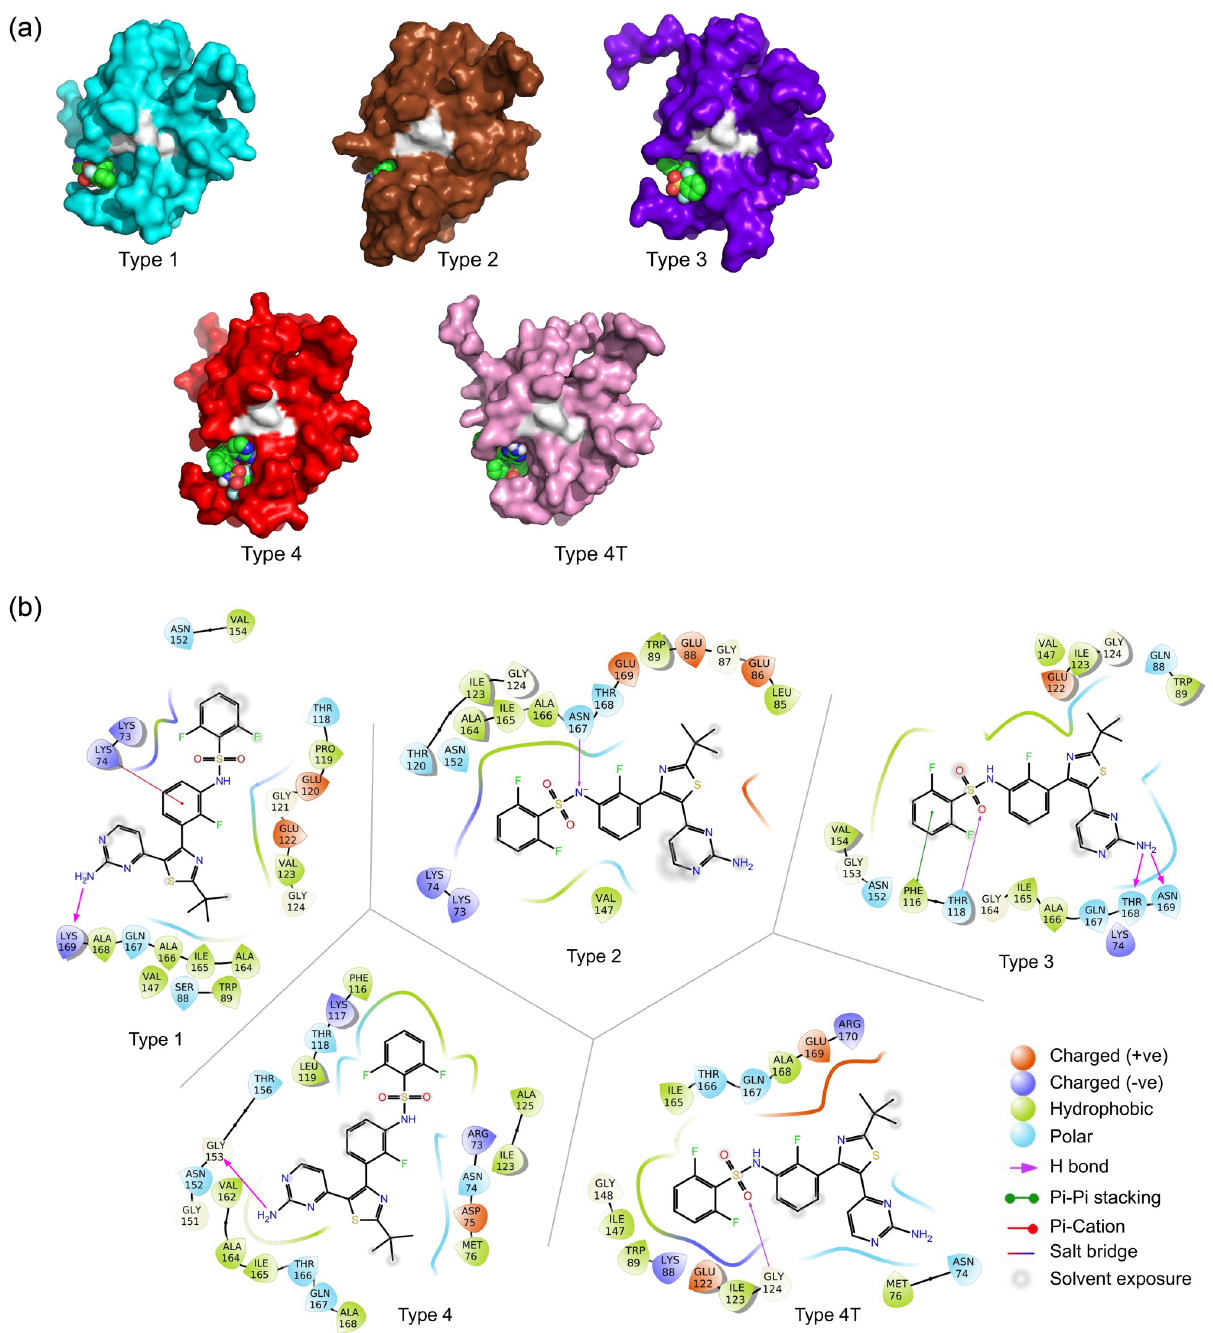
Fig 4. a. Graphical representation of detailed surface interaction of dabrafenib with the allosteric binding site residues of all five DENV proteases as obtained by molecular docking. b. 2D interaction diagram of dabrafenib with the binding site residues of all five DENV proteases as obtained by molecular docking. (A) Interaction of dabrafenib with the binding site residues of type 1 DENV protease (PDB: 3L6P). (B) Interaction of dabrafenib with the binding site residues of type 2 DENV protease (PDB: 4M9T). (C) Interaction of dabrafenib with the binding site residues of type 3 DENV protease (PDB: 3U1J). (D) Interaction of dabrafenib with the binding site residues of type 4 DENV protease (PDB: 2VBC). (E) Interaction of dabrafenib with the binding site residues of type 4T DENV protease (PDB: 2WHX).